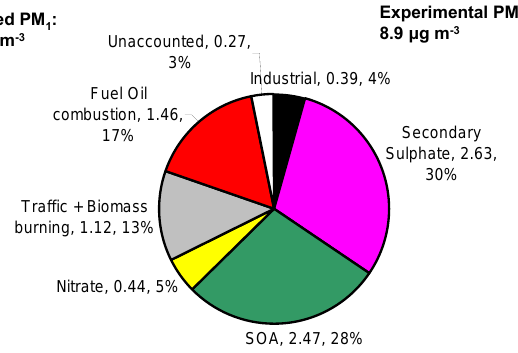
Fig. 3. Average contribution of each source (µgm − 3 ) to PM 1 ob- tained by